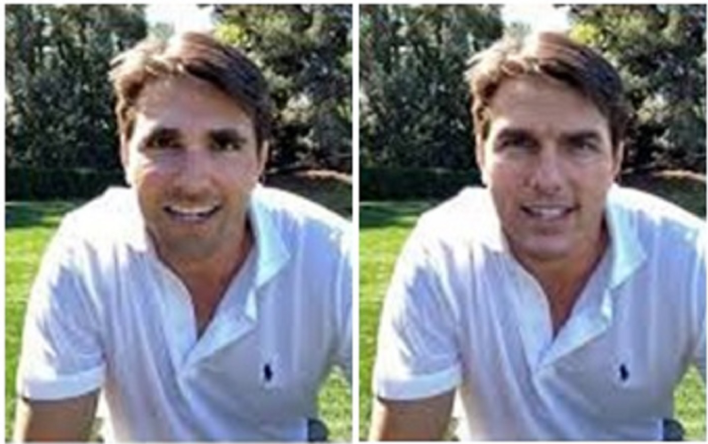
Figure 9. Deepfake and original image: Original image ( left ), deepfake ( right )